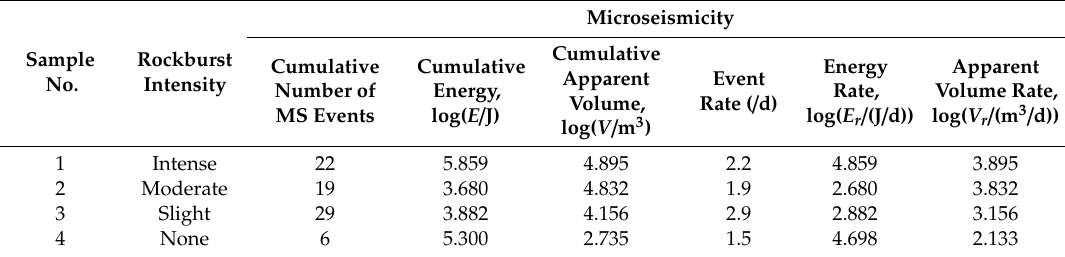
Table 1. Details of the sample events.